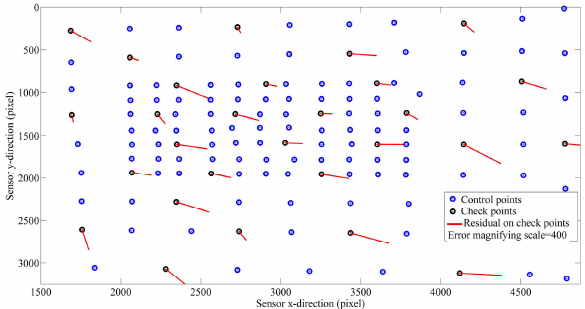
Figure 2. Integration scheme of the system and its components Figure 3. Residuals on checkpoints after camera